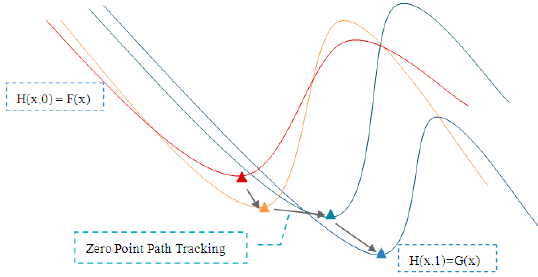
Figure 4. A series of homotopic deformations.